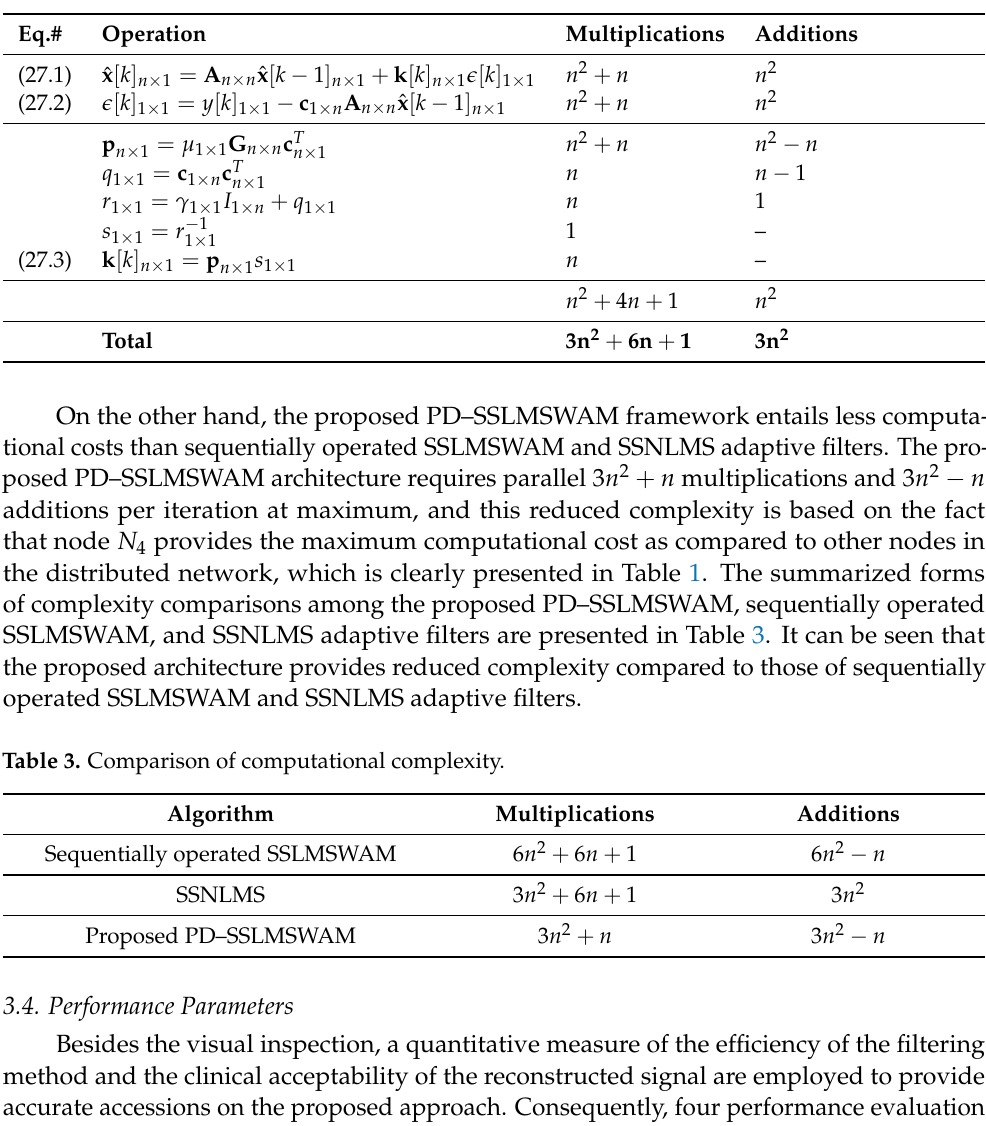
Table 2. Computational complexity of the SSNLMS mentioned in Equation (27).